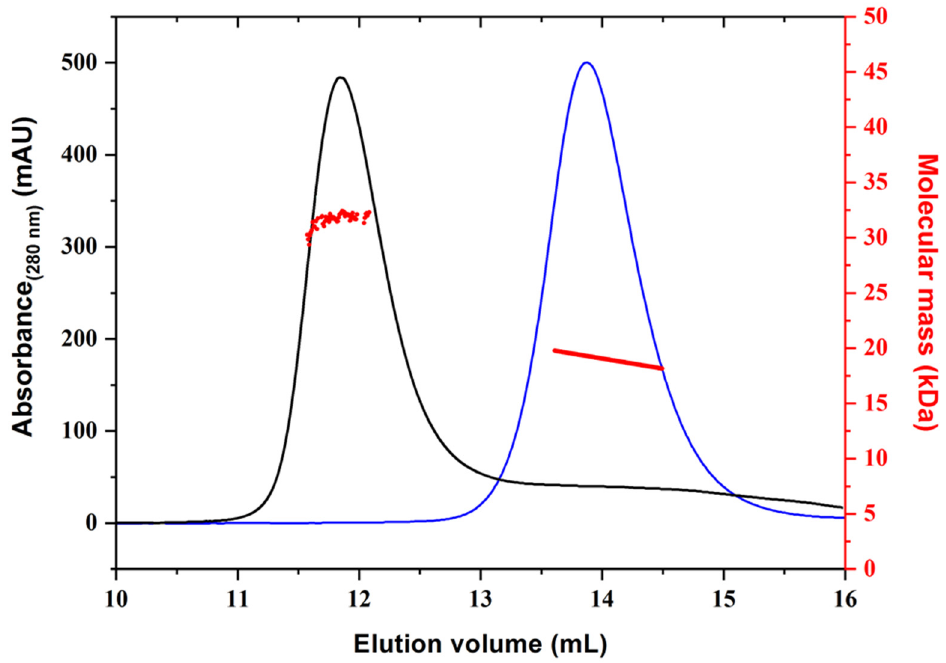
Figure 2. Light scattering measurements. The plots report the molecular mass and absorbance (280 nm) versus the elution volume for Gal-1 (black line) and Gal-3 CRD (blue line). Table 1. Static light scattering analysis of Gal-1 and Gal-3. Protein Theoretical MW a Experimental MW Ratio Exp/Theor Gal-1 17842 (Da) 35684 ± 105 (Da) 1.98 Gal-3 CRD 18863 (Da) 19050 ± 171 (Da) 1.01